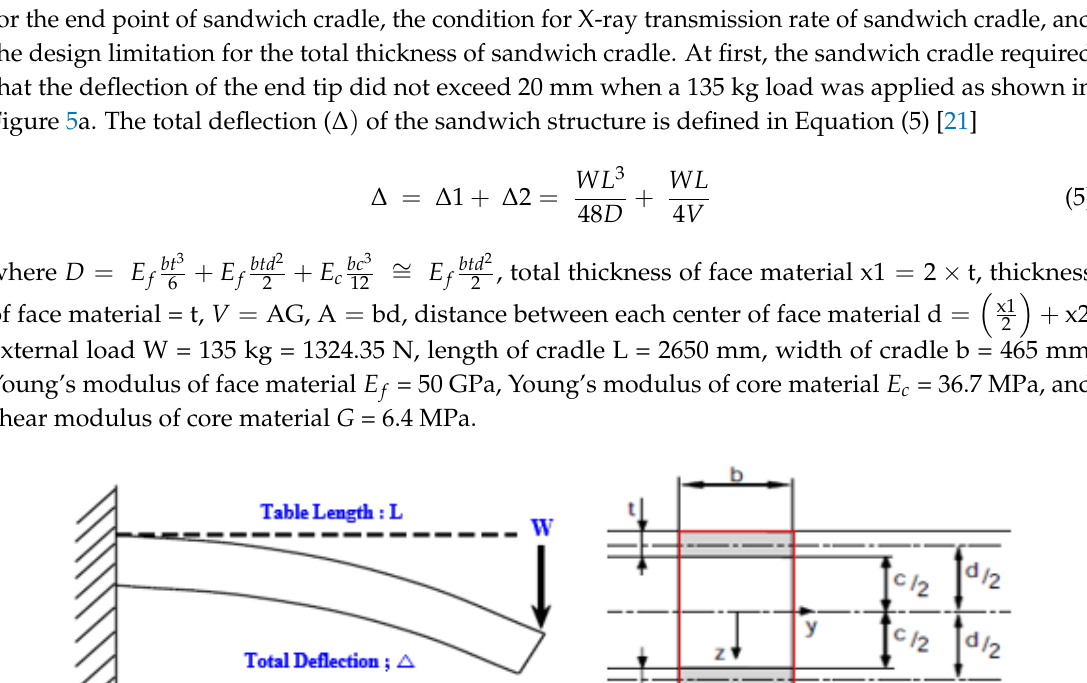
Figure 4. Shape of Sandwich composite Cradle; ( a ) 3-dimensional Shape of Cradle, ( b ) design of Core and the reinforced block.